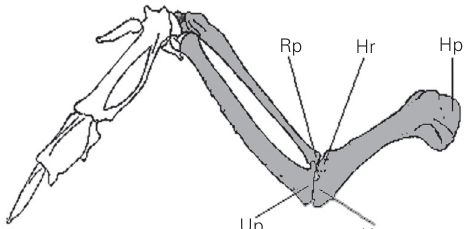
Figure 1. Schematic drawing in- dicating the anatomical regions of chicken wing cartilage used in this study. Hp = proximal hu- merus; Hr = distal humerus in contact with the radius; Hu = distal humerus in contact with the ulna; Rp = proximal radius; Up = proximal